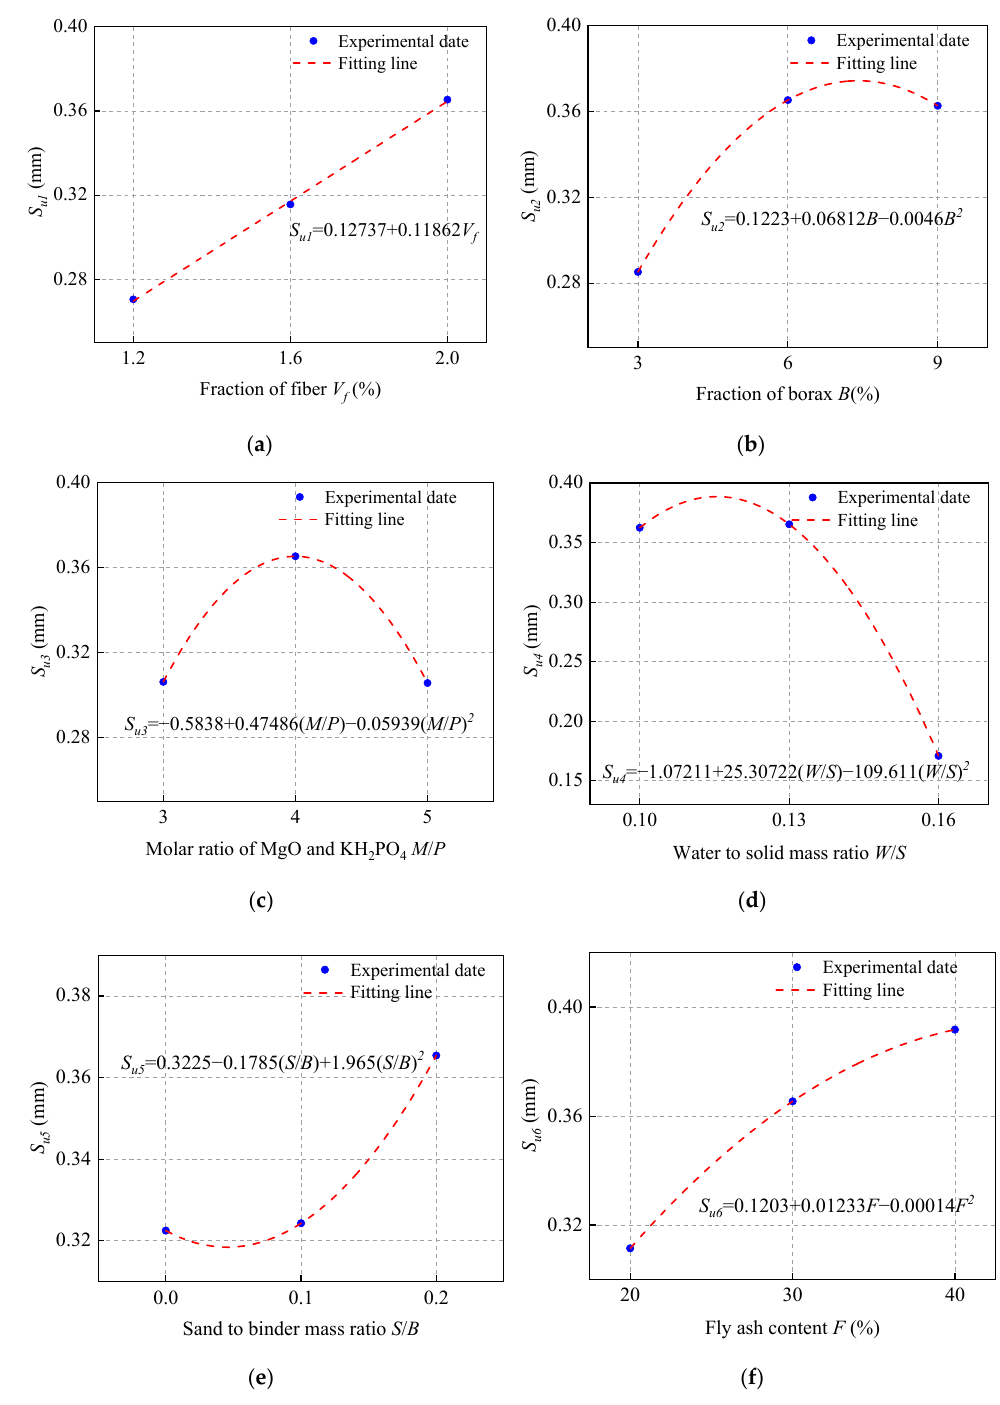
Figure 14. The fitting calculation of ( a ) S u 1 ; ( b ) S u 2 ; ( c ) S u 3 ; ( d ) S u 4 ; ( e ) S u 5 ; ( f ) S u 6 .